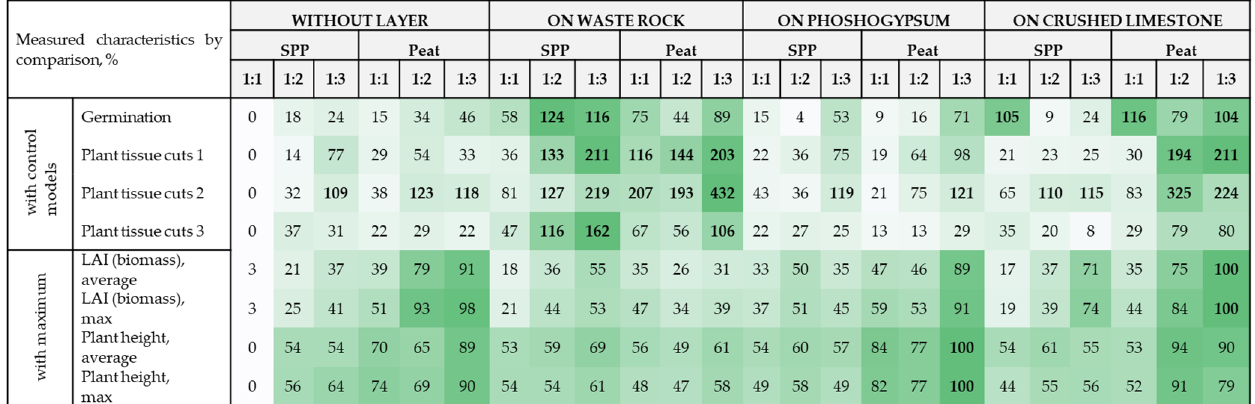
Figure 9. Measured characteristics in comparison with control models/maximum.